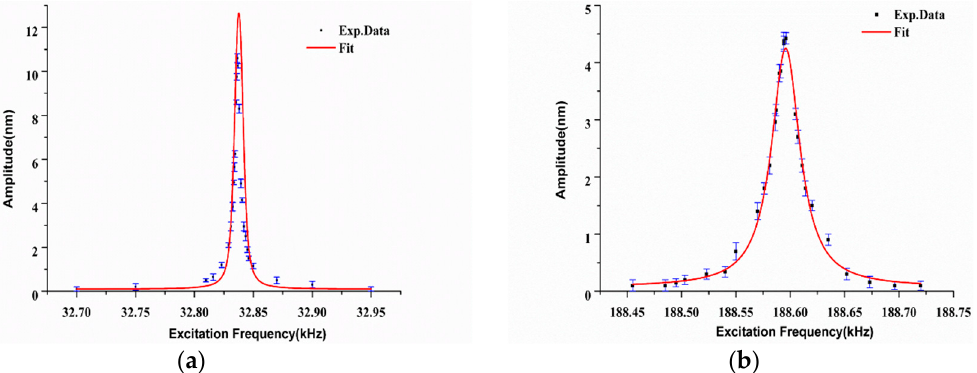
Figure 3. The typical experiment amplitude-frequency curve of the QTF lateral (shear) vibrating at the ( a ) low mode and ( b ) high mode.